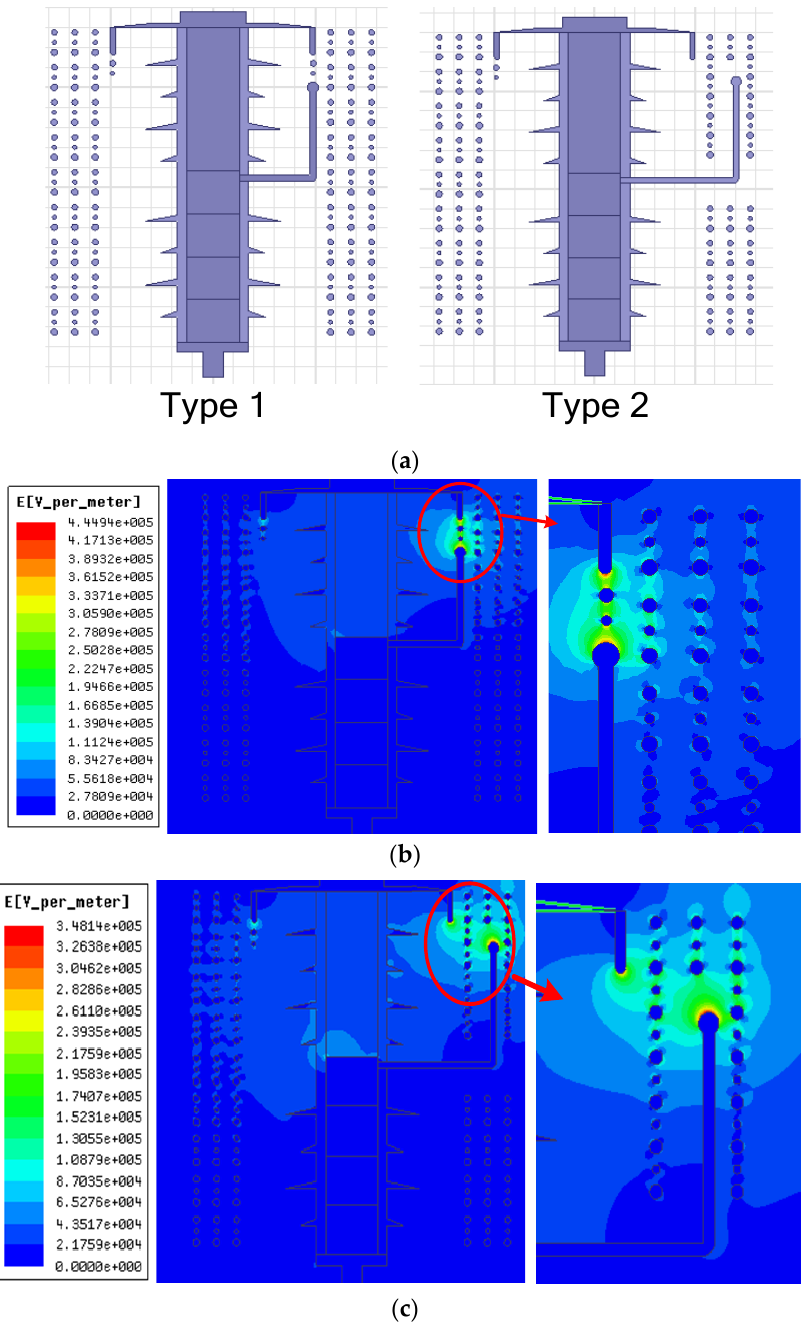
Figure 6. Electric field distribution under rain conditions: ( a ) Simulation model; ( b ) type 1; ( c ) type 2.